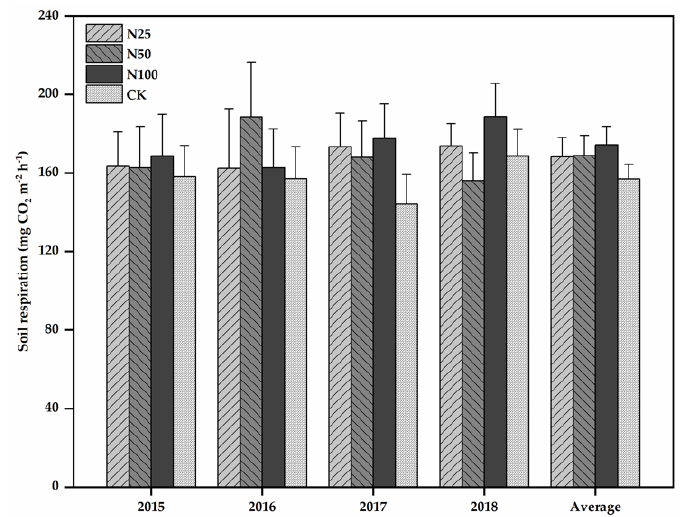
Figure 2. Mean R S in 2015, 2016, 2017, 2018, and four-year average for each treatment. N25, N50, N100, and CK represent 25, 50, 100, and 0 kg N ha −1 a −1 N addition treatments, respectively. Error bars denote the standard errors of the means. No significant variations were found among the four N treatments across each year by one-way ANOVA.